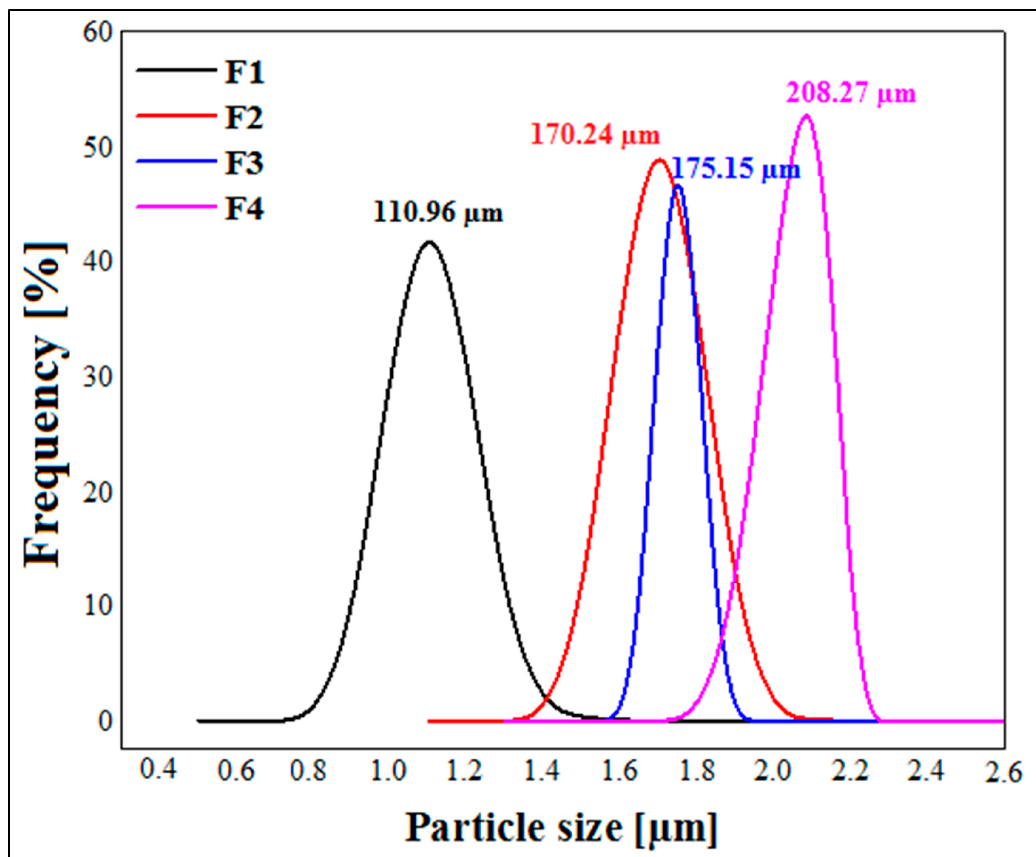
Figure 5. Particle size measurements of dried metformin hydrochloride microspheres .